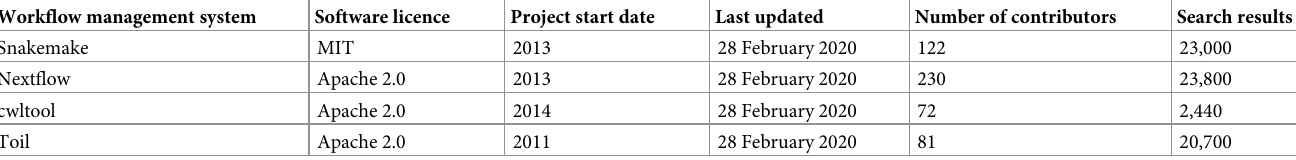
Table 3. Statistics on the shortlisted workflow management